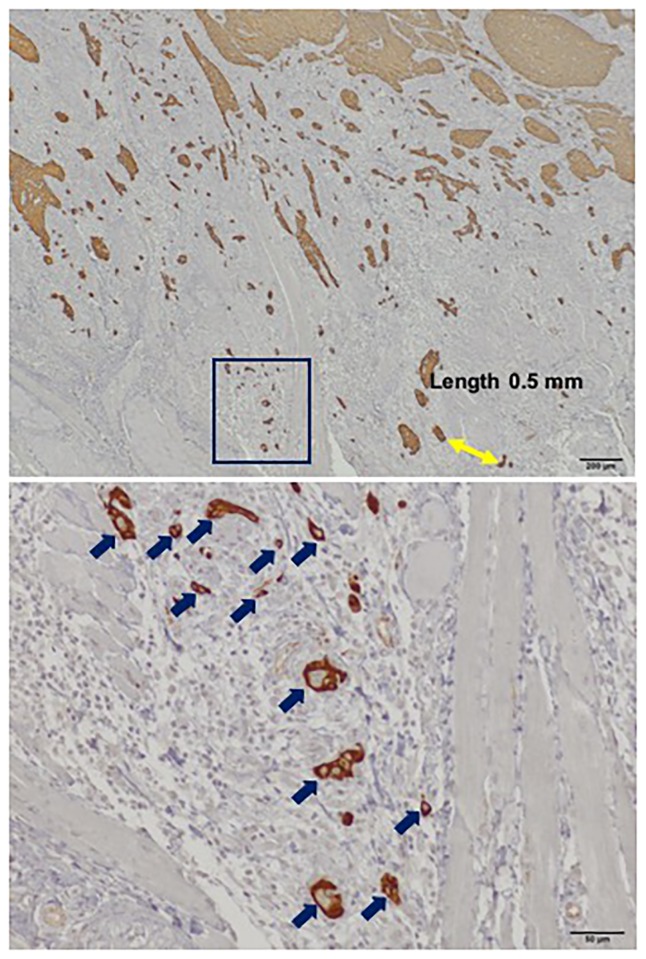
Photographs of immunohistochemical pancytokeratin staining show representative examples of grade 4D mode of invasion and worst pattern of invasion (WPOI)-4 at x40 magnification.The region in the rectangle is shown at x200 magnification in the lower panel, which shows 12 buds.